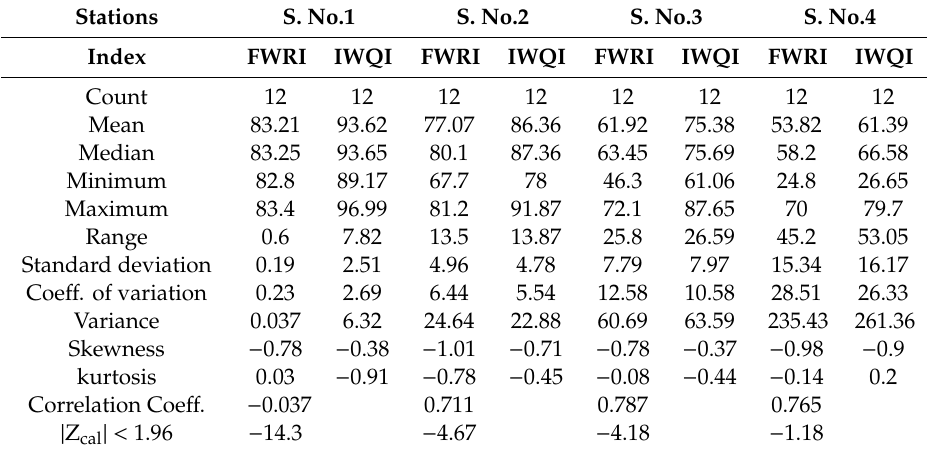
Table 8. Statistical properties of FWRI and IWQI values at the four stations.